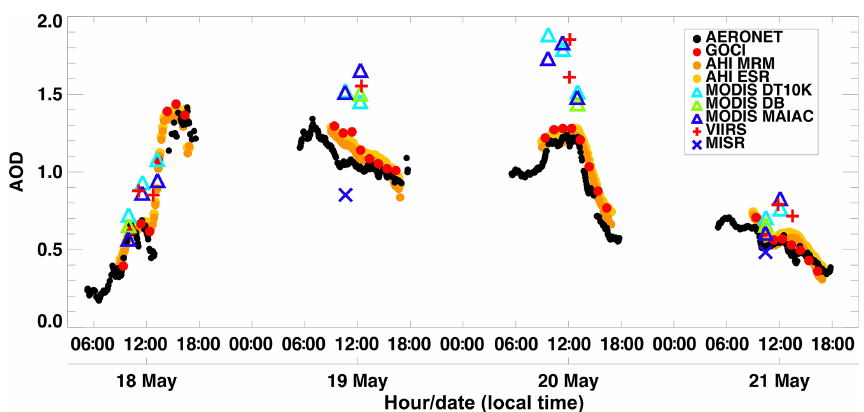
Figure 5. Time series of multiple satellite AODs and AERONET AOD at the Hokkaido University site during 18–21 May